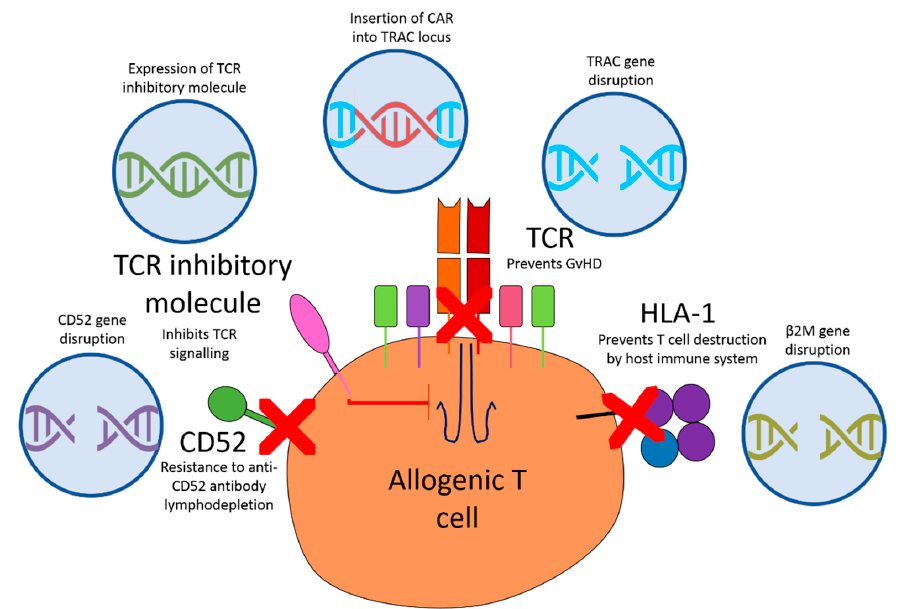
Figure 2: Diagram illustrating genetic modifications that can be made to donor αβ T cells to make allogenic CAR T cell therapy possible. To prevent GvHD the αβ TCR must be disrupted. This can be achieved by inserting the CAR construct into the TRAC locus or by knocking down the TRAC gene using TALENs, ZFNs or CRISPR/Cas9 to prevent TCR expression. Additionally, a TCR inhibitory molecule can introduced to the cells to prevent TCR signalling. CD52 gene disruption has also been used to provide the allogenic T cells with resistance to lymphodepletion. To prevent destruction of the allogeneic cells by the host immune system, the B2M locus can be disrupted. This prevents the formation of HLA-1 molecules on the surface of the T cells and prevents them from being recognised as